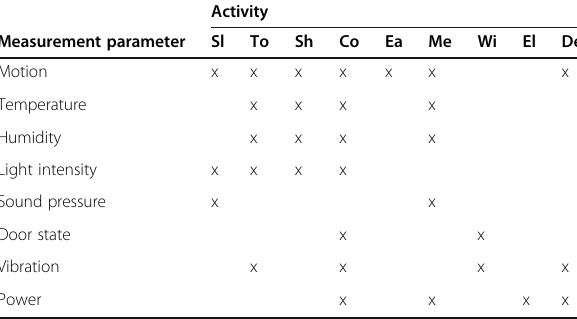
Table 1 (abstract P4). Summary of our mapping of measurement parameters to activities we wish to detect. Sl=Sleeping, To=Toiletting,